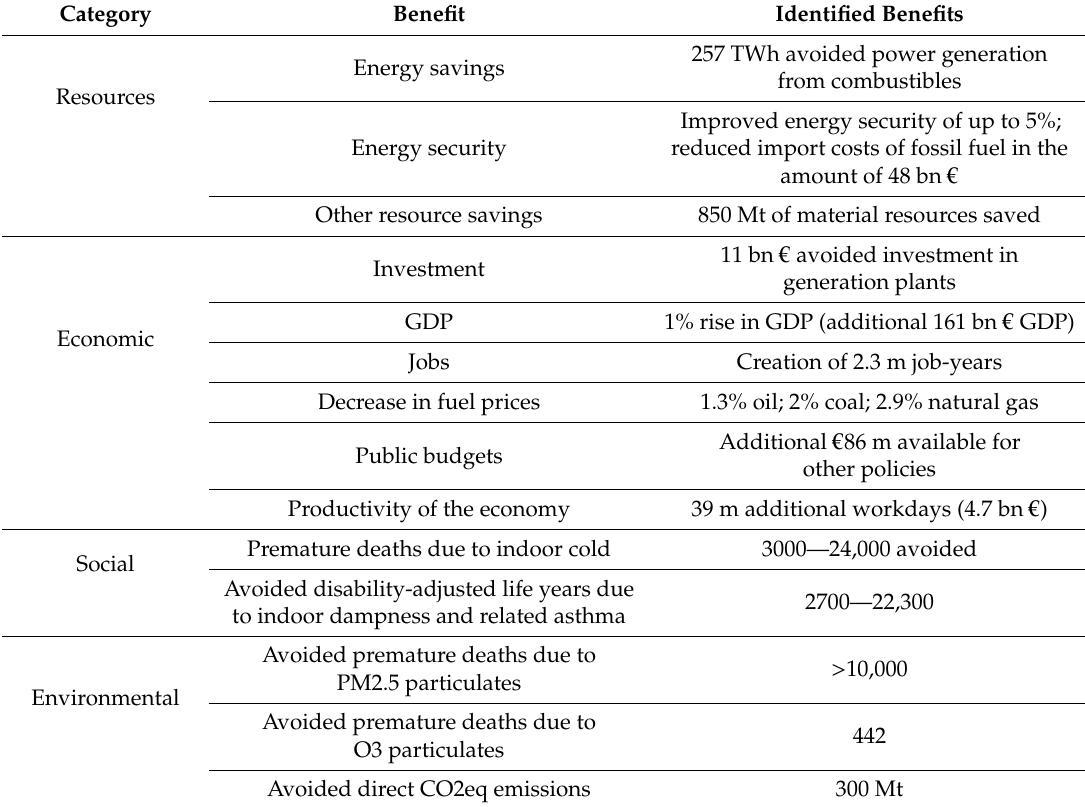
Figure 1. Concepts of multiple benefits: IEA concept and relation to green growth. Sources: [1,44]. Table 1. Multiple impacts of additional EU energy e ffi ciency policies (annual; 2030 time horizon). Category Benefit Identified